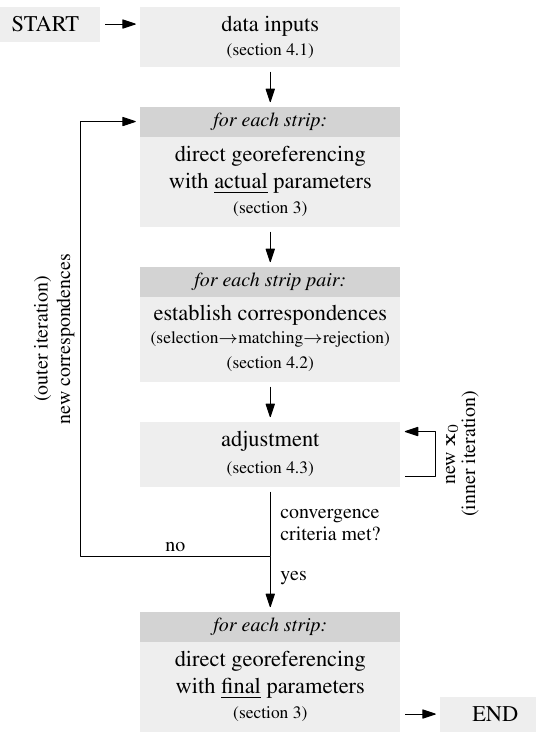
Figure 3: Flowchart of strip adjustment method.